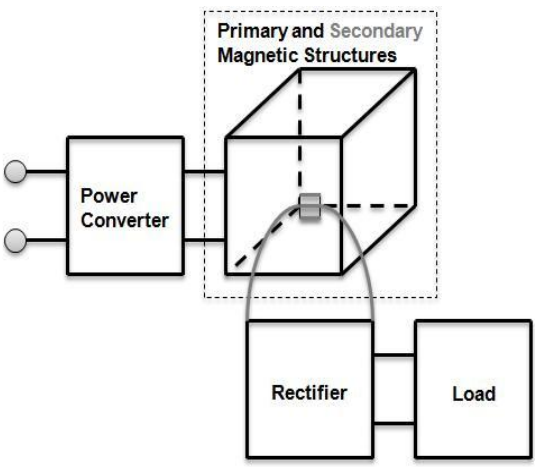
Figure 1: Structure of the proposed ICPT